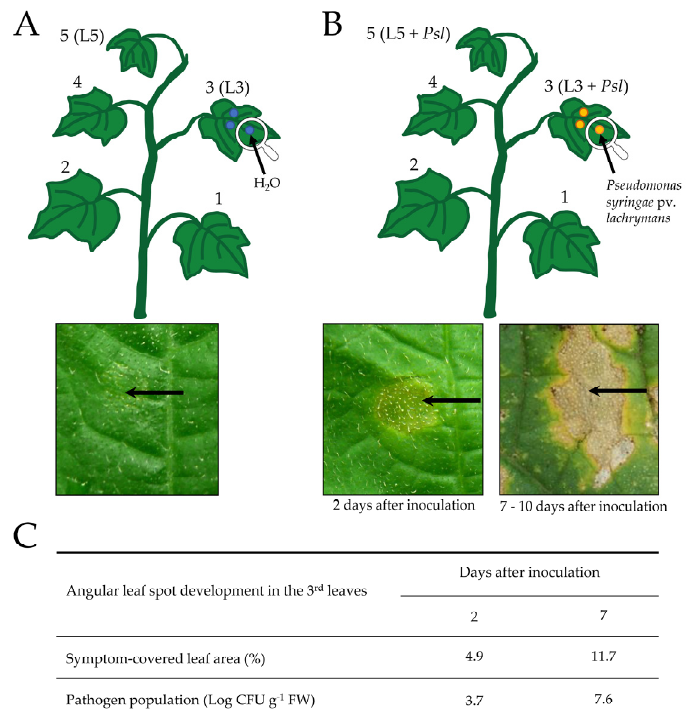
Figure A1. The experimental model and angular leaf spot disease development. ( A ) The third leaves of cucumber plants were treated with sterile distilled water (L3) or ( B ) inoculated with Psl (L3 + Psl ). The intact fifth leaves were collected from distilled water-treated (L5) or Psl -inoculated plants (L5 + Psl ). Disease symptoms were recorded 2 and 7–10 days after inoculation. Macro photographs were taken with Panasonic DMC-FZ50 camera equipped with a close-up lens; 1–5–leaf position. ( C ) Disease severity progress was given as the percentage of the total leaf area covered with symptoms. The leaf images scanned to JPEG files were subjected to the automatic analysis and classification described by Goc ł awski et al. [93]. The quantification of Psl population in the L3 + Psl leaves was according to Jacob et al. [94]. Table A1. Nicotinamide adenine dinucleotides redox ratios in cucumber leaves after Pseudomonas syringae pv lachrymans infection. Redox Ratio